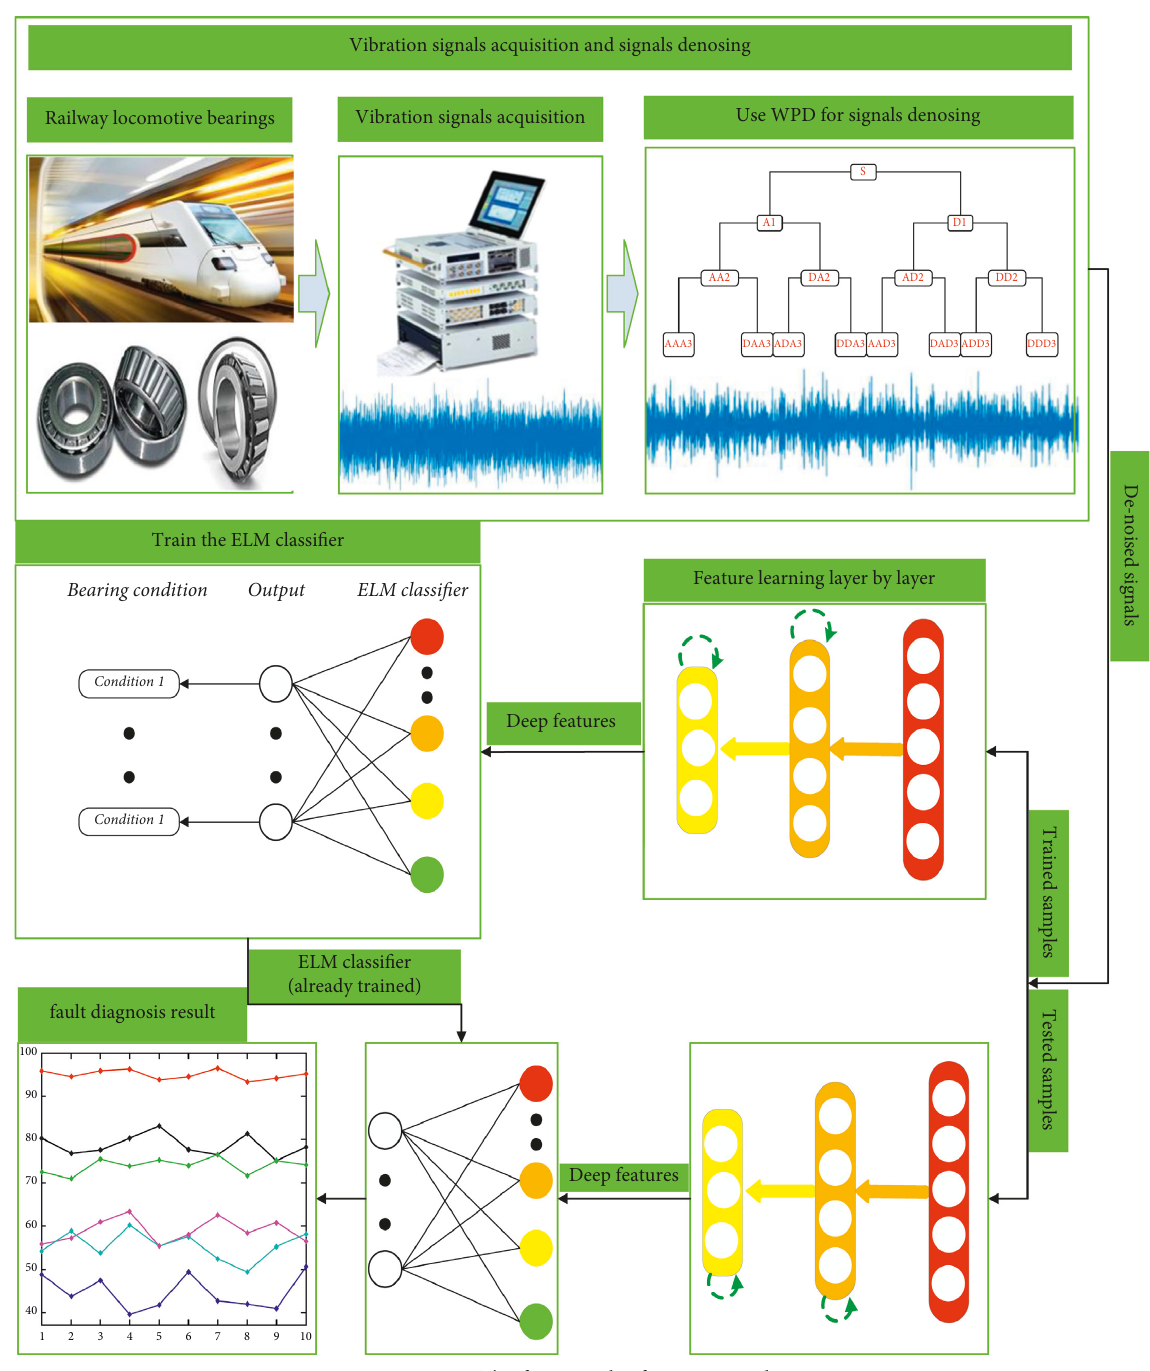
Figure 5: The framework of our